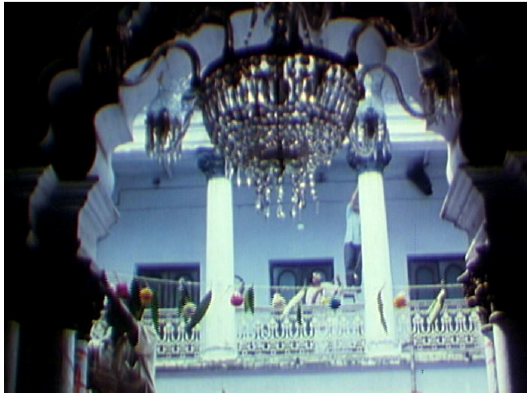
Figure 6. Scalloped arch with sola (pith) decorations strung across, screen grab, Utsab